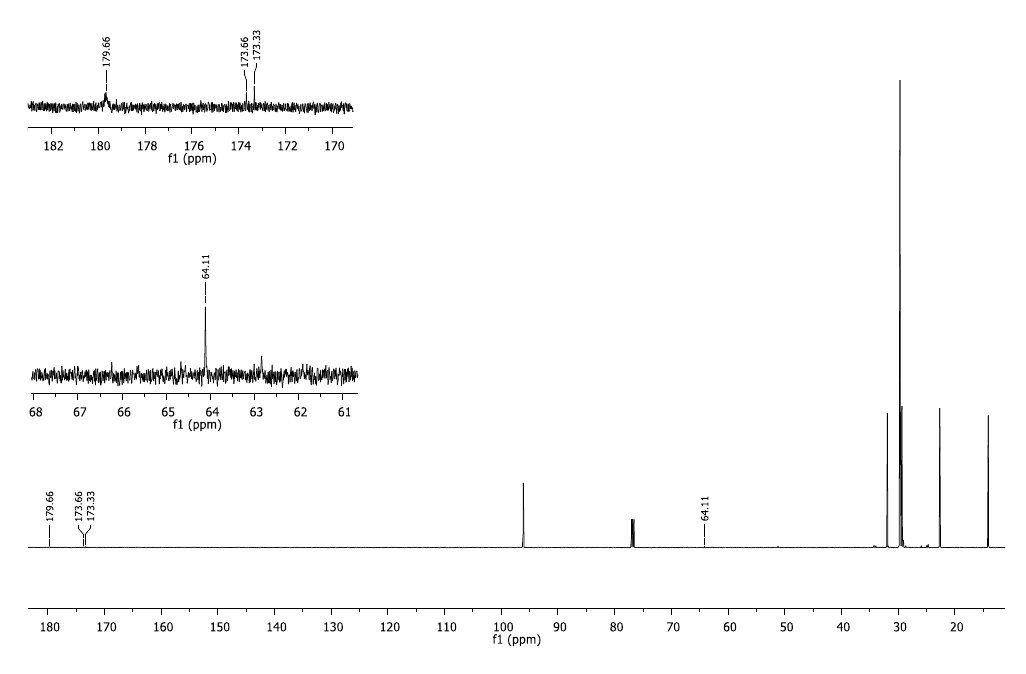
Figure 17. 13 C NMR spectrum for deoxygenated canola FAME product.